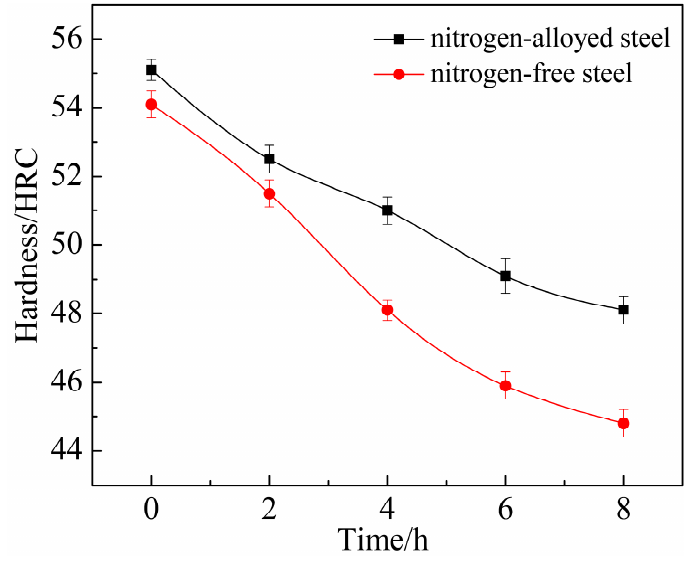
Figure 2. Hardness of tested steel tempered at 600 °C for various holding times.